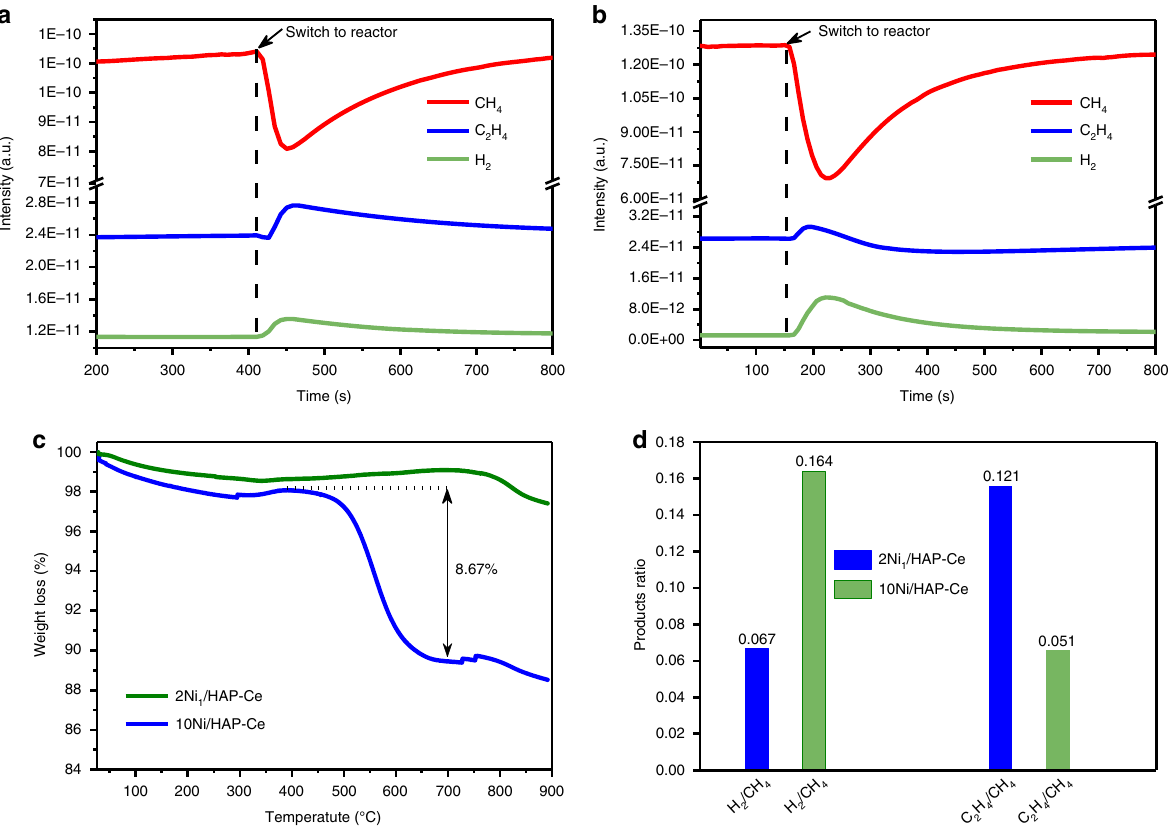
Fig. 5 CH 4 decomposition and products distribution over Ni/HAP-Ce catalysts. a Mass spectrometer signals during CH 4 decomposition at 750°C of 2Ni 1 / HAP-Ce and b 10Ni/HAP-Ce, c TGA analysis of both catalysts after 1 h of reaction, and d product ratios for non-oxidative methane decomposition. H 2 /CH 4 and C 2 H 4 /CH 4 represent the mass spectrometer product ratio of H 2 and C 2 H 4 relative to the amount of CH 4